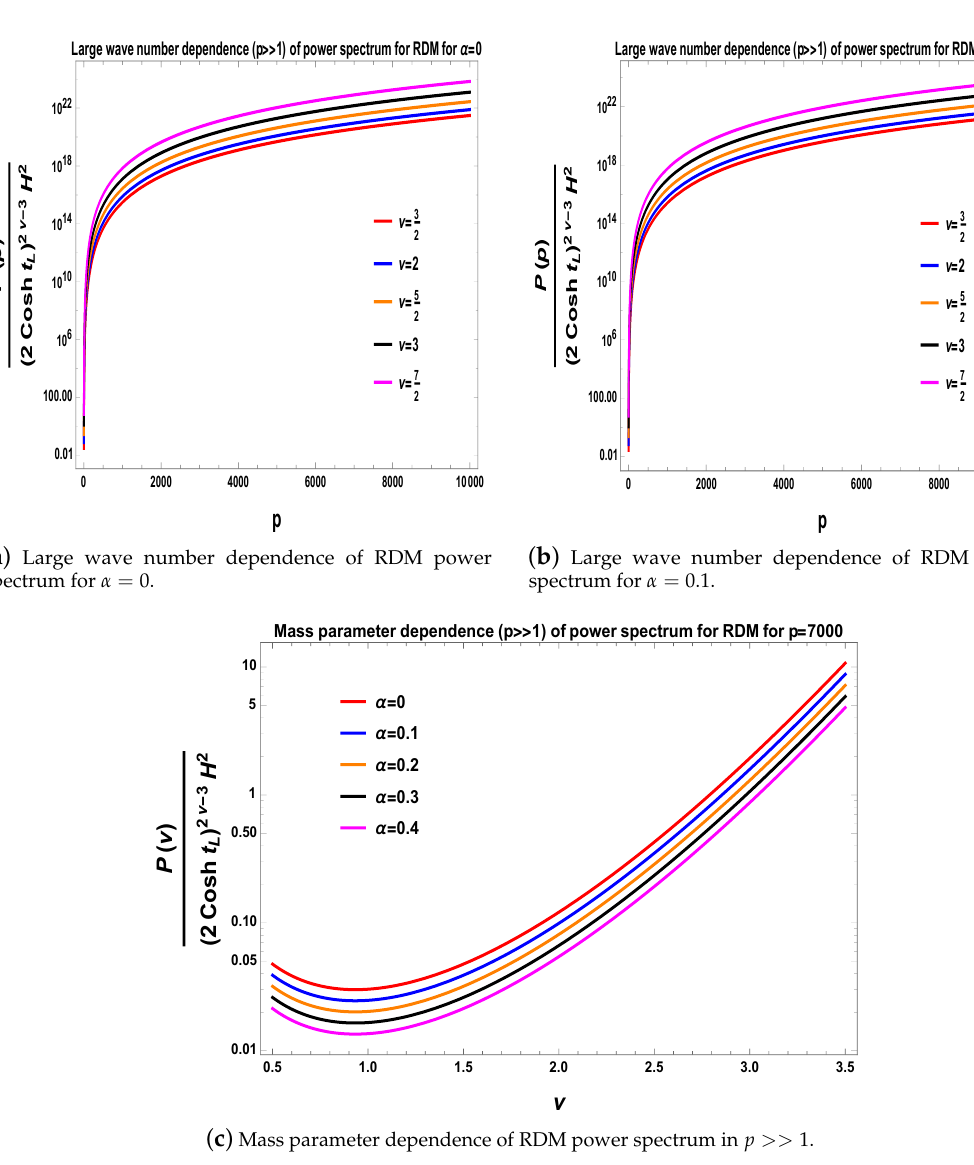
Figure 9. Features of RDM power spectrum in large wave number region. ( a ) Large wave number dependence of RDM power spectrum for α = 0; ( b ) Large wave number dependence of RDM power spectrum for α = 0.1.; ( c ) Mass parameter dependence of RDM power spectrum in p >>